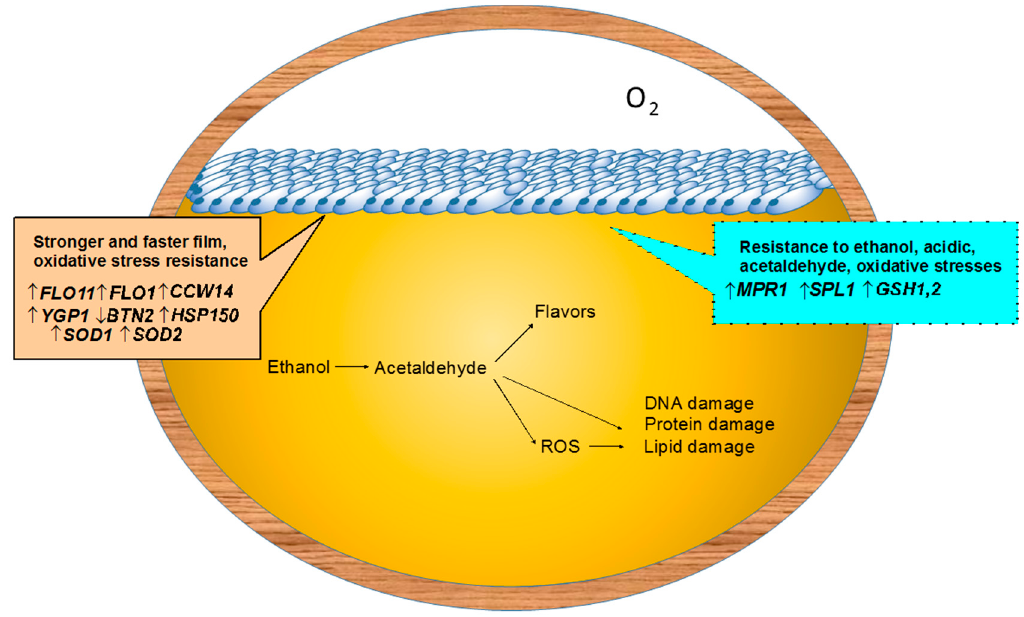
Figure 2. Targets for genetic improvement of flor yeast strains. Explored genes are outlined in beige, promising targets – in blue.